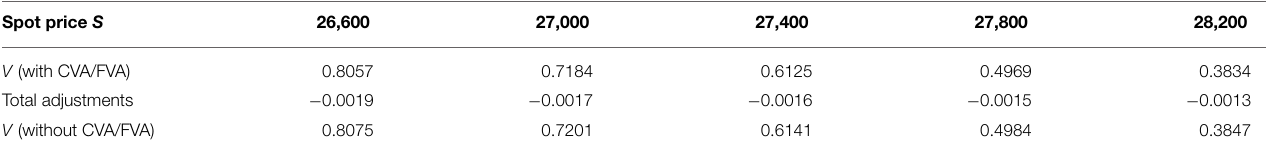
TABLE 8 | Prices of digital put under KoBoL process as of 28 May 2015, time to maturity T = 0 . 0877 , strike K = 27 , 400 , risk-free rate r = 0 . 25 % , collateral rate